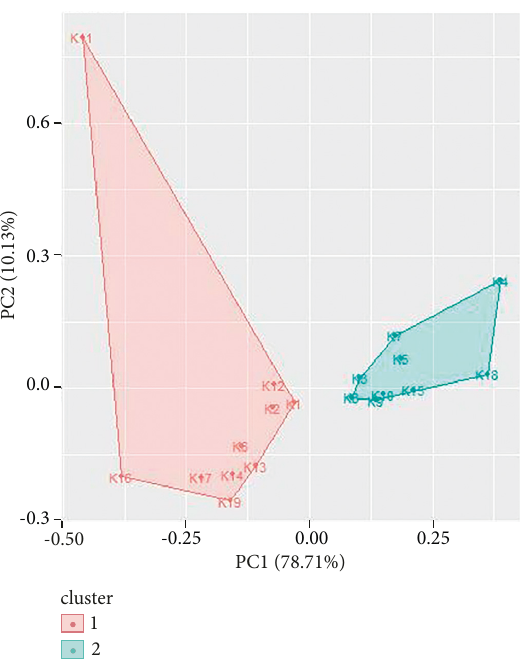
Figure 14: Cluster analysis for FTIR spectroscopy data for black ballpoint pen